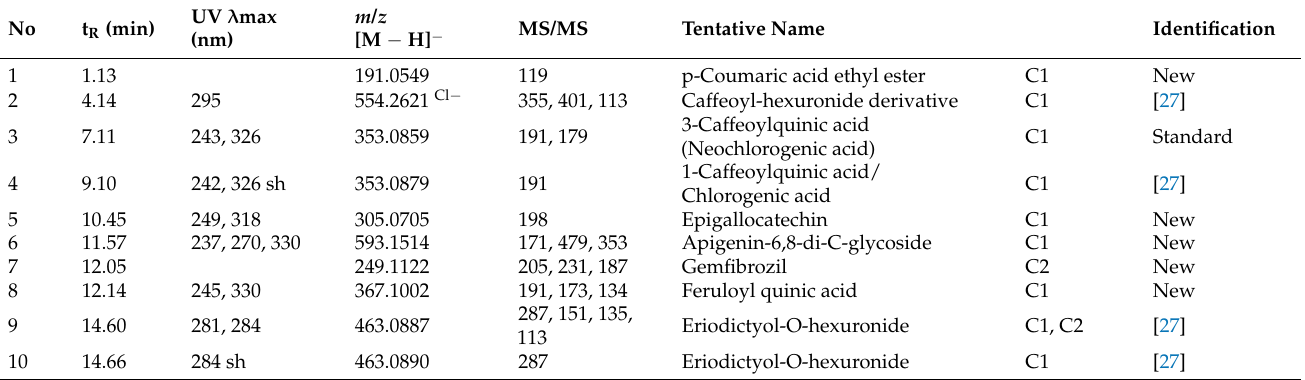
Table 2. Phytochemicals screened from the methanol (C1) and chloroform (C2) extracts of E. africanus in the negative ion